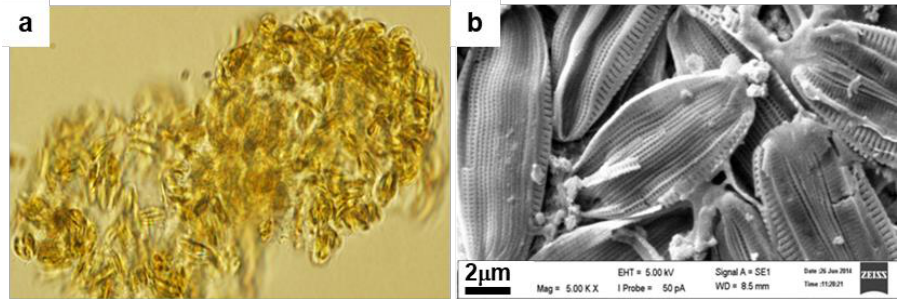
Figure 2. Fluorescence micrograph ( a ) and scanning electron micrograph ( b ) of Amphora copulata .